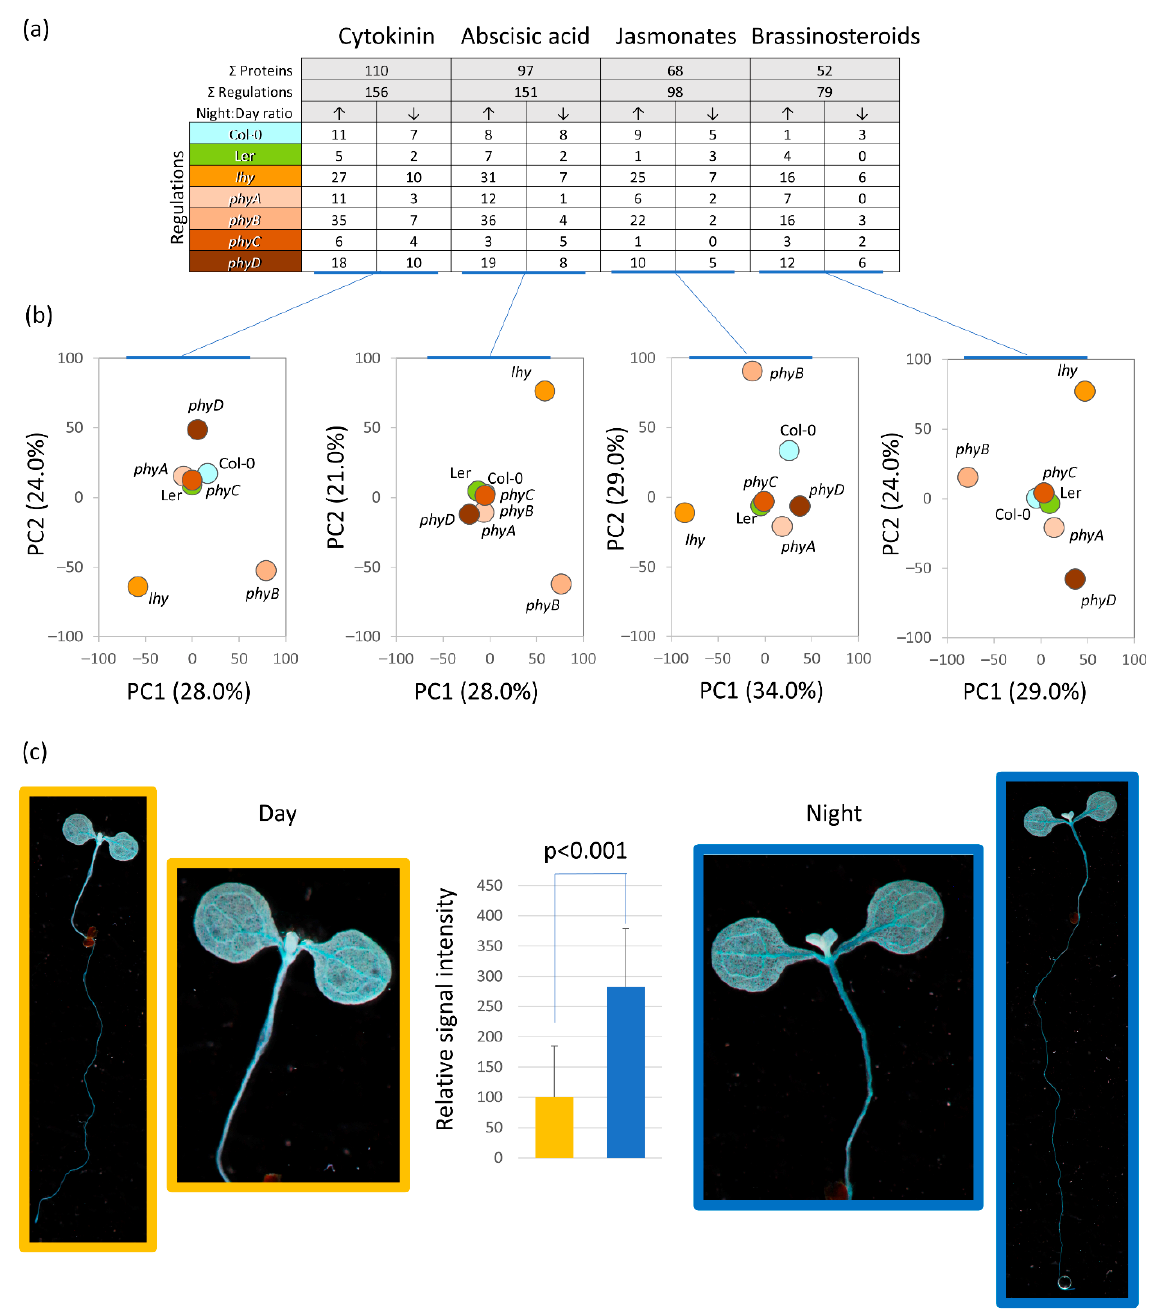
Figure 8. Role of phytohormones in the night–day proteome regulation. ( a ) Phytohormone response proteins found in the dataset and ( b ) corresponding PCA representations of regulations found in individual genotypes. For details, see Supplementary Table S1. ( c ) Cytokinin signaling is upregulated in the dark. Representative images of the transgenic line ARR5::GUS seedlings collected in the middle of the day and in the middle of the night and stained for GUS activity. The results of the quantitative analysis represent means and standard deviations of nine biological replicates, significance represents Student’s t -test.